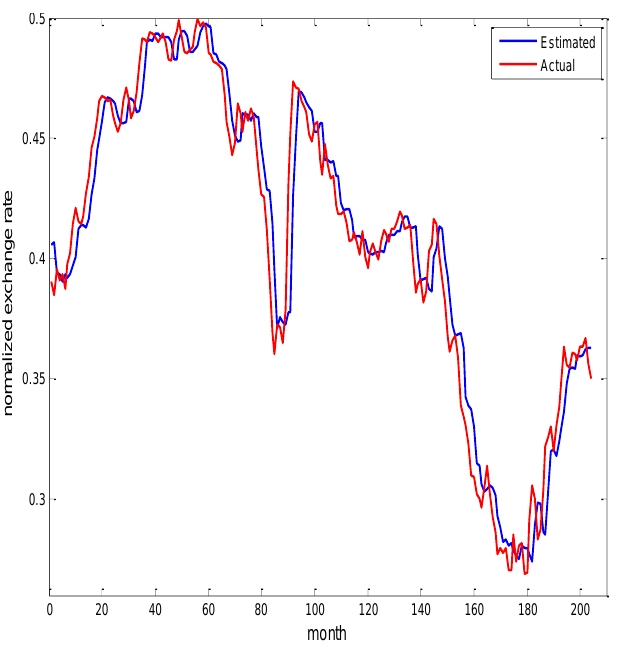
Figure 14 . Actual v/s estimated exchange rate prices for Australian dollar/Dollar by combined method (simple